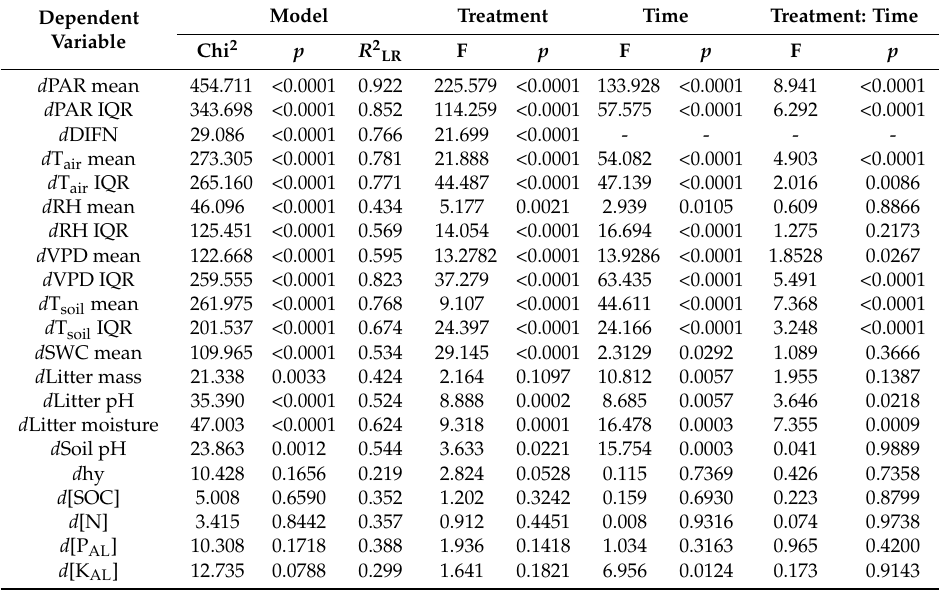
Table 2. The results of the linear mixed effects models performed for site condition